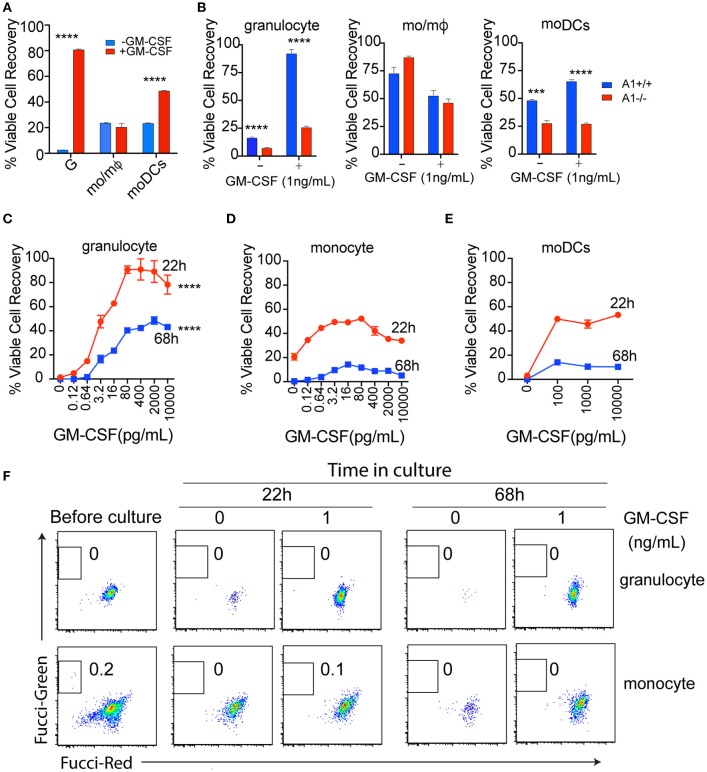
The effect of GM-CSF dose on myeloid cell survival in culture. (A) Granulocytes, moDCs and mo/mΦ were purified from WT BM cultures by flow sorting, then were cultured with or without 10 ng/mL GM-CSF for 22 h. The total recovery of viable (PI excluding) cells was presented. ****p < 0.0001 (student's t-test). Data are from one of 3 repeated experiments. (B) Granulocytes, moDCs and mo/mΦ were purified from WT and A1−/− BM cultures by flow sorting, then were cultured with or 1 ng/mL GM-CSF for 22 h. The total recovery of viable (PI excluding) cells was presented. ***p < 0.001, ****p < 0.0001 (student's t-test). Data are from one of 3 repeated experiments. (C,D) Granulocytes and monocytes were isolated and purified from WT mice blood, then cultured with or without different doses of GM-CSF for 22 and 68 h. ****p < 0.0001(ANOVA). Data are from one of 3 repeated experiments. (E) moDCs were isolated and purified from GMtg mice spleen, then cultured with or without different doses of GM-CSF for 22 or 68 h. (F) To exclude the possibility that increased recovery of viable cells under GM-CSF stimulation was due to cell proliferation, granulocytes and monocytes from Fucci mice blood were isolated and purified, then cultured with or without different doses of GM-CSF. Data are from one of 3 repeated experiments.